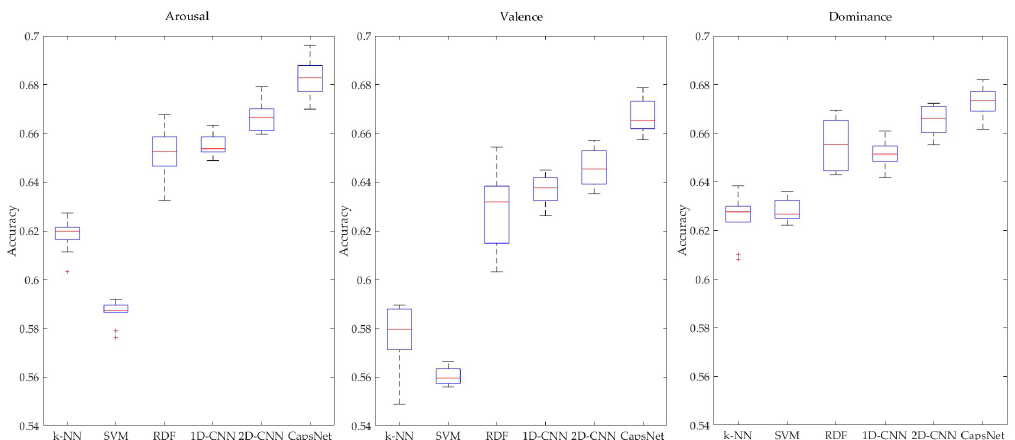
Figure 9. Comparison of emotion recognition results between CapsNet and comparison classifiers.